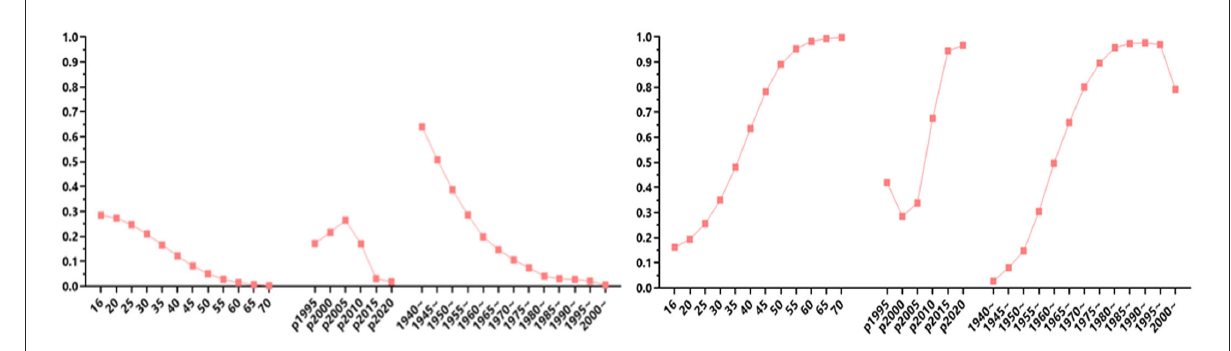
FIGURE1 Estimation of age-period-cohort effect on the trends of human immunodeficiency virus (HIV) infection via blood transmission (left) and via sexual intercourse (right) during 1995–2020 in Hubei, China.